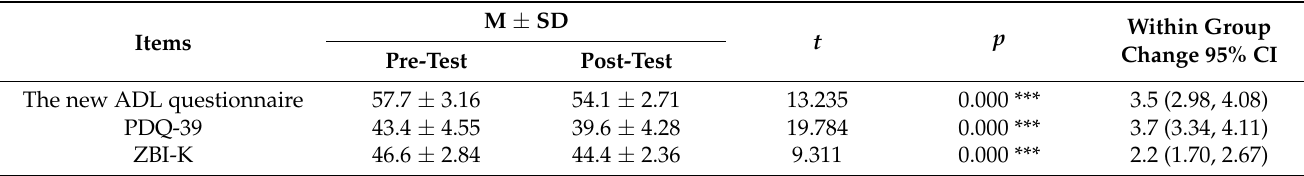
Table 3. Traditional Rehabilitation Changes.